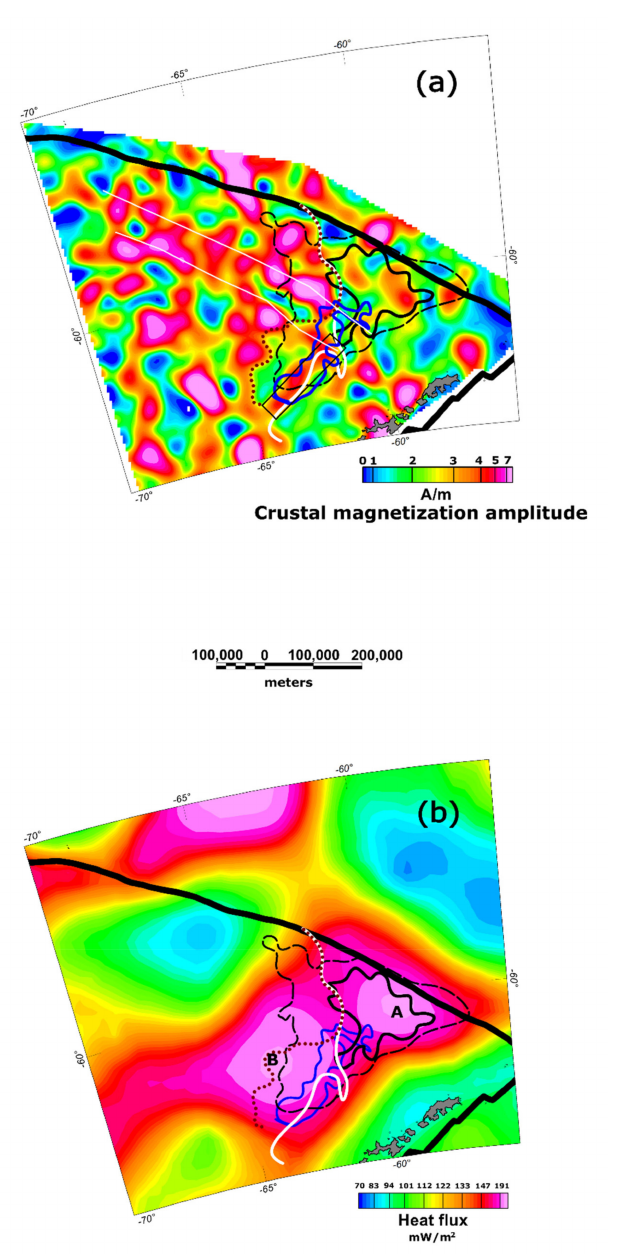
Figure 7. ( a ) Spatial variation of the magnetization pattern. Two white solid lines separate plate segments P1, P2, and P3. ( b ) The figure shows the heat flux map from Martos et al. (2019). Letters “A” and “B” denote two heat flux maxima. A brown curvilinear dotted line denotes the new boundary depicting where magnetization decreases, while a thick solid white line denotes the proposed magnetization boundary in Figure 5b. A rectangle (only in Figure 7a) denotes an area where magnetization increases (see text for comments). A thin black dashed polygon denotes the location of a triangular Bouguer maxima anomaly area, and a thick black solid polygon denotes the area where highest values are reached within this section. A blue solid line denotes the location of the flexural